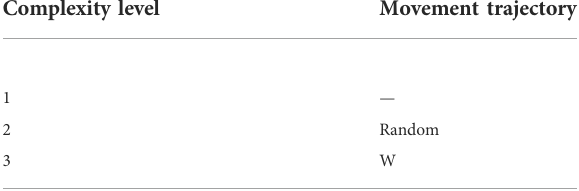
TABLE 2 Task complexity and movement trajectory.